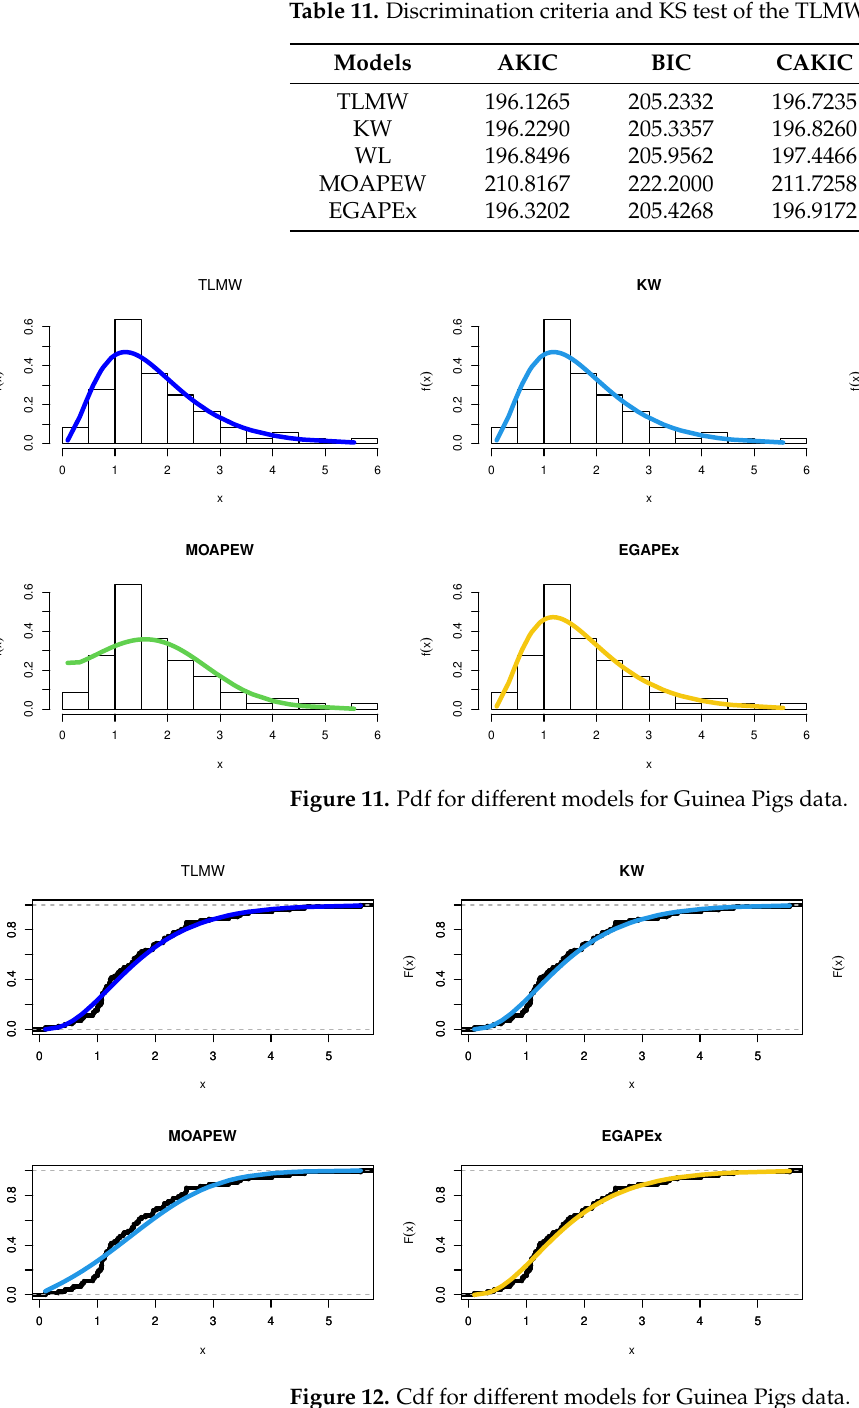
Figure 12. Cdf for different models for Guinea Pigs